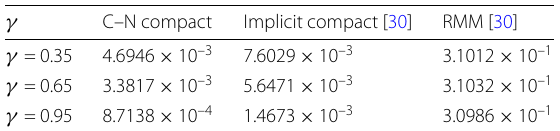
Table 6 Comparison between proposed method when h = 1 radial basis functions method for Test problem 2